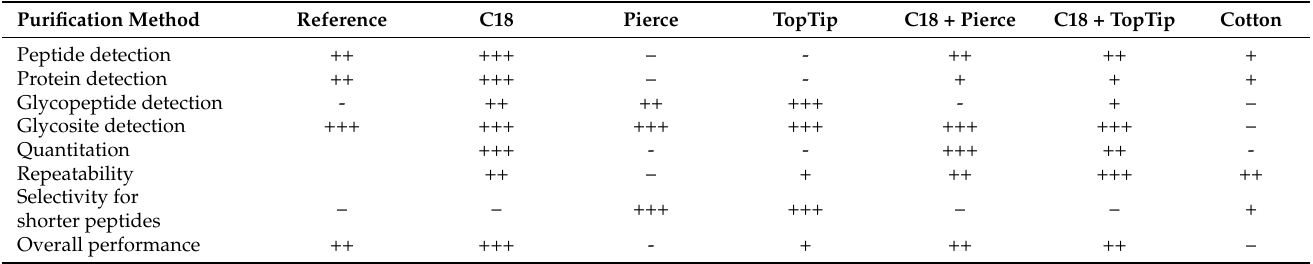
Table 1. Summary of the performance of the different SPE methods discussed. (+++ means best, – means worst performance characteristics, relative to the other methods).